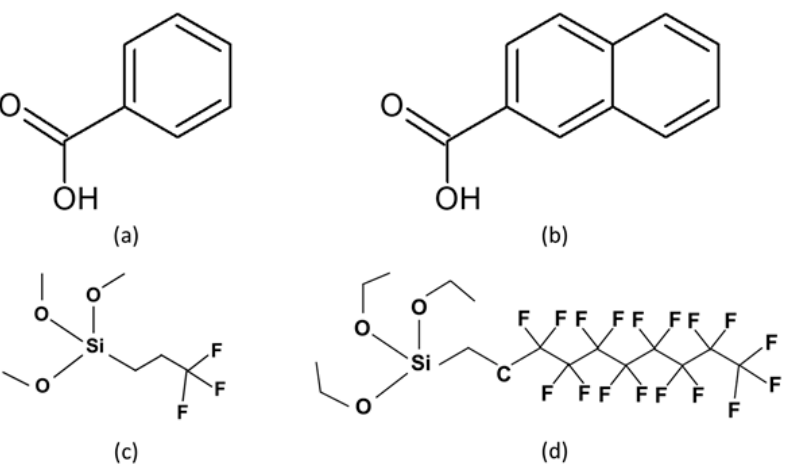
Figure 1. Molecular structures of the self-assembled monolayer (SAM) precursors ( a ) benzoic acid (BA), ( b ) 2-naphthoic acid (NA), ( c ) (3,3,3-trifluoropropyl)trimethoxysilane (F-3SAM), and ( d ) (heptadecafluoro-1,1,2,2-tetrahydrodecyl)triethoxysilane (F-10SAM).